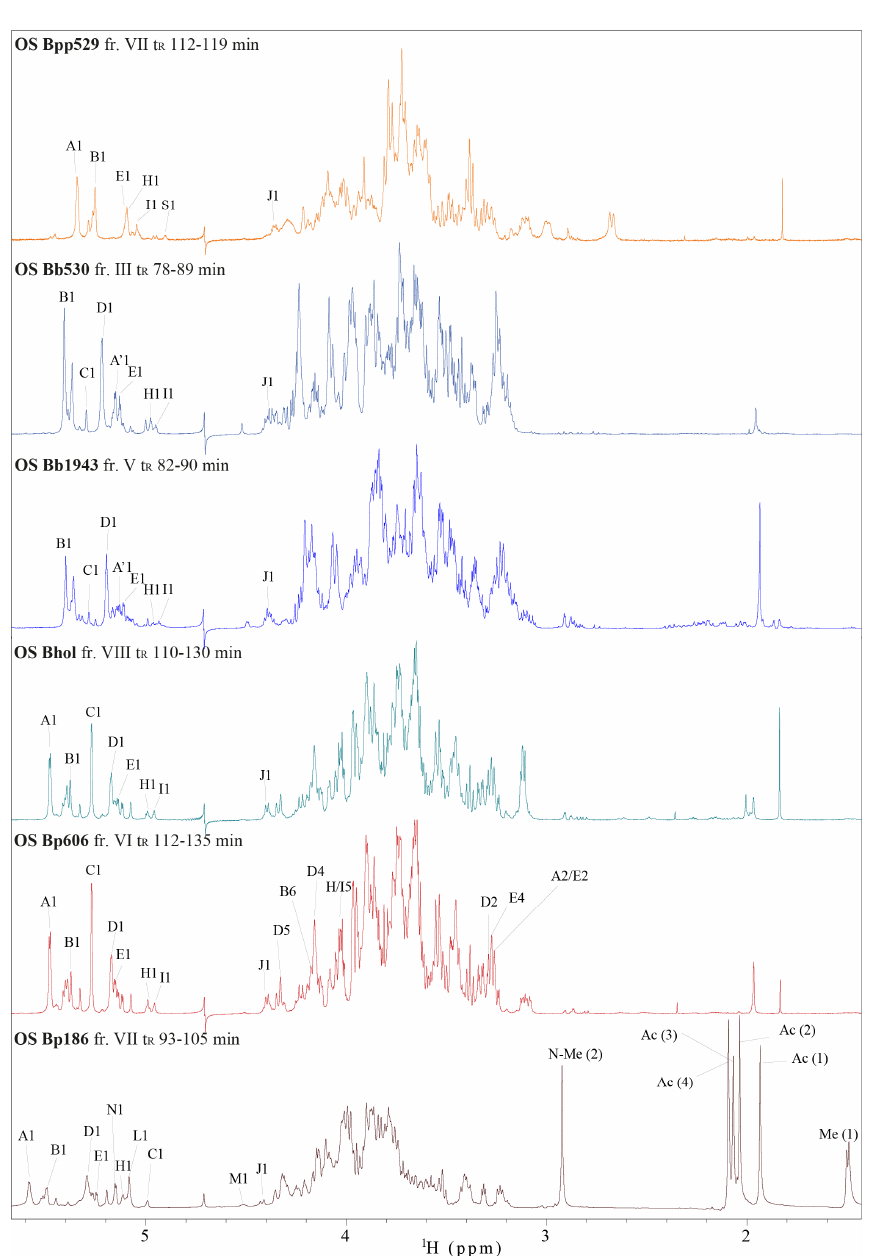
Figure 3. Structure-reporter groups in the 1 H NMR spectra of the Bordetellae oligosaccharides: B. pertussis strain 186, B. pertussis strain 606, B. holmesii ATCC 51541, B. bronchiseptica PCM 1943, B. bronchiseptica PCM 530, and B. parapertussis PCM 529. The capital letters and numbers indicate protons in respective monosaccharides. The resolved resonances in the anomeric regions as well as the characteristic signals of the trisaccharide in the structure of B. pertussis 186 lipooligosaccharide (LOS) are indicated. Me(1), an exocyclic CH 3 , N-Me(2), N-methyl at C-4, and Ac(4), N-acetyl of residue M ; Ac(1) and Ac(3), N-acetyls of the residue L at C-2 and C-3, respectively; Ac(2), N-acetyl of residue N . The bold was used to increase visibility of the indicated residues throughout the text.